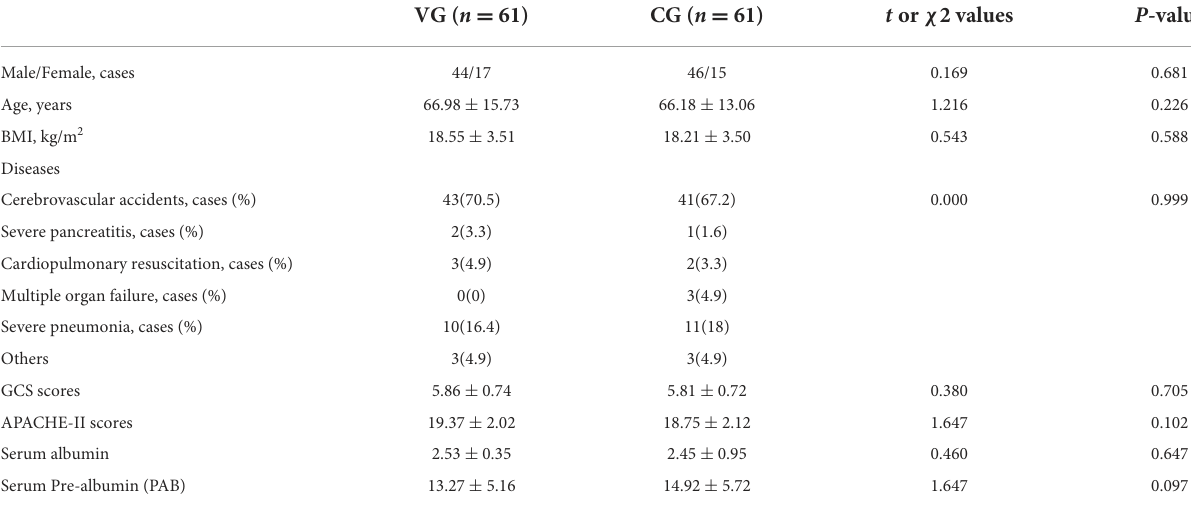
TABLE 1 Baseline characteristics of the patients receiving nasojejunal indwelling feeding tube.